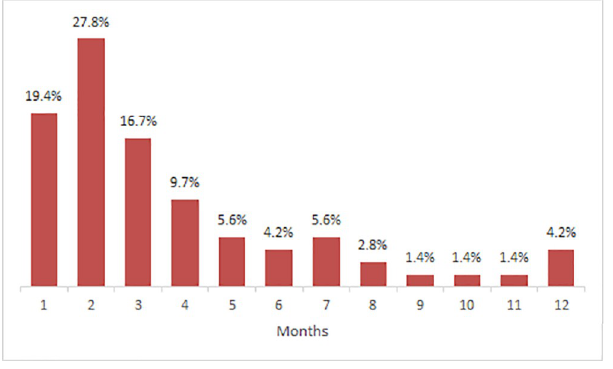
Fig 2. Time to contraceptive use after delivery (N =